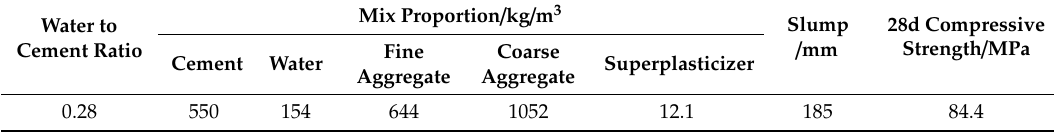
Table 2. Mix proportion, slump and 28d compressive strength of HPC.